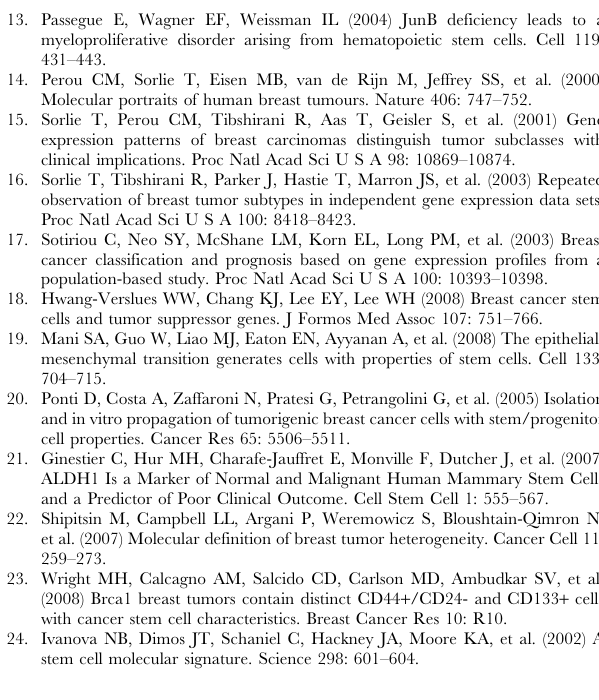
showed that the PROCR + /ESA + cells retained at a small percentage (0.6%) and asymmetrically divided into PROCR 2 /